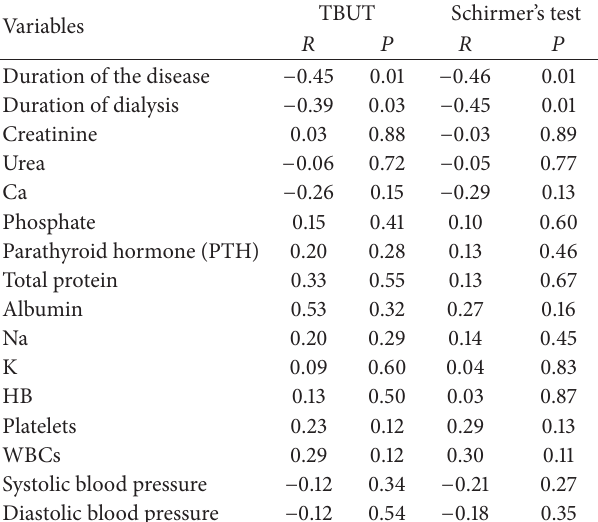
Table 4: Correlation between TBUT and Schirmer’s test results and ESRF-related